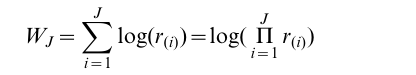
Figure 2. Power of the five methods for different proportions ( a ) of associated SNPs within a pathway of size 60. Plots illustrate the power of the methods when the total number of associated SNPs equals 100 (plot (A)) and 200 (plot(B)), the effect sizes are s 2 both plots.